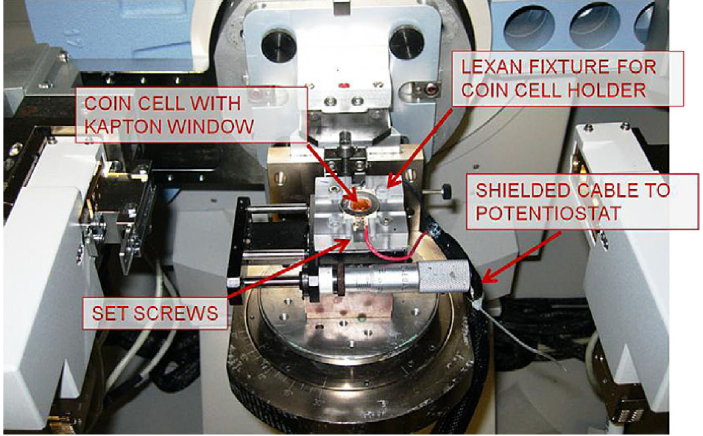
Figure 1. In situ XRD setup Reprinted with permission from ref. [27]. Copyright 2012